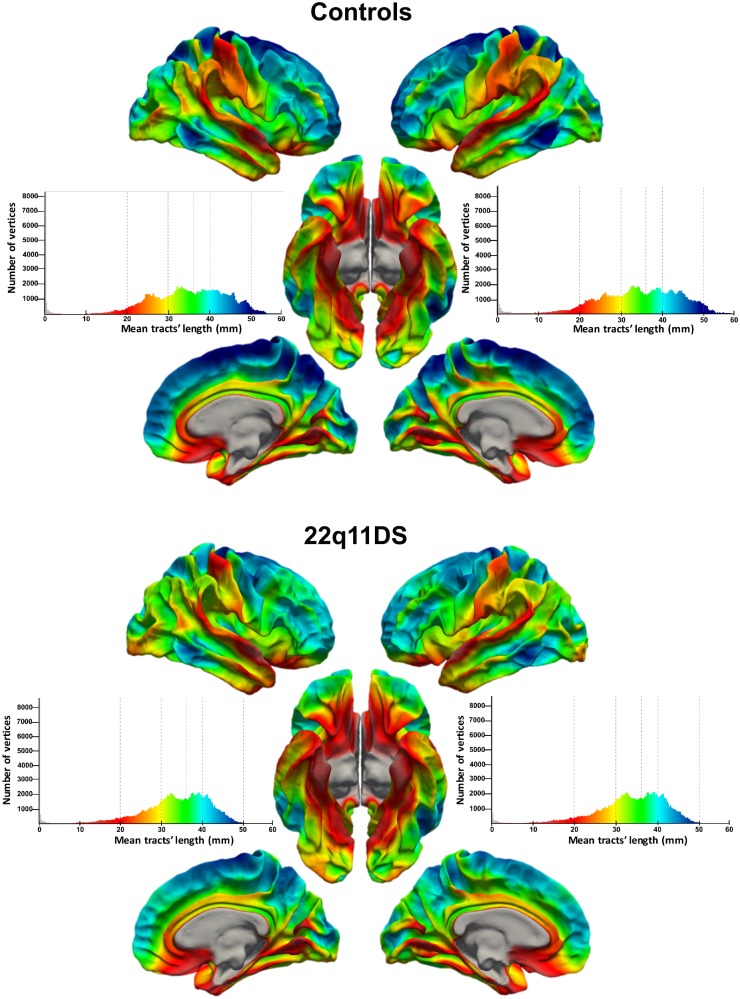
Cortical maps of the mean tracts’ length and corresponding histograms.The maps represent the average measures of mean tracts’ length for each group. The dorsomedial cortical regions had longer streamlines, followed by ventromedial prefrontal regions, post-central and prefrontal cortices.